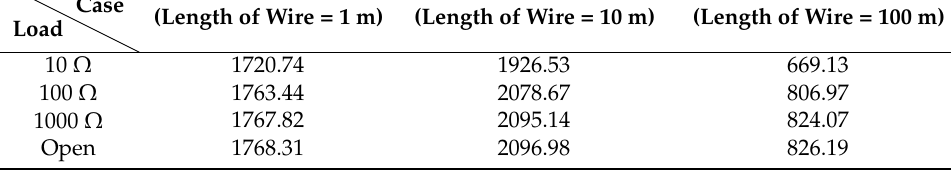
Table 7. The results in case 4 (Unit: